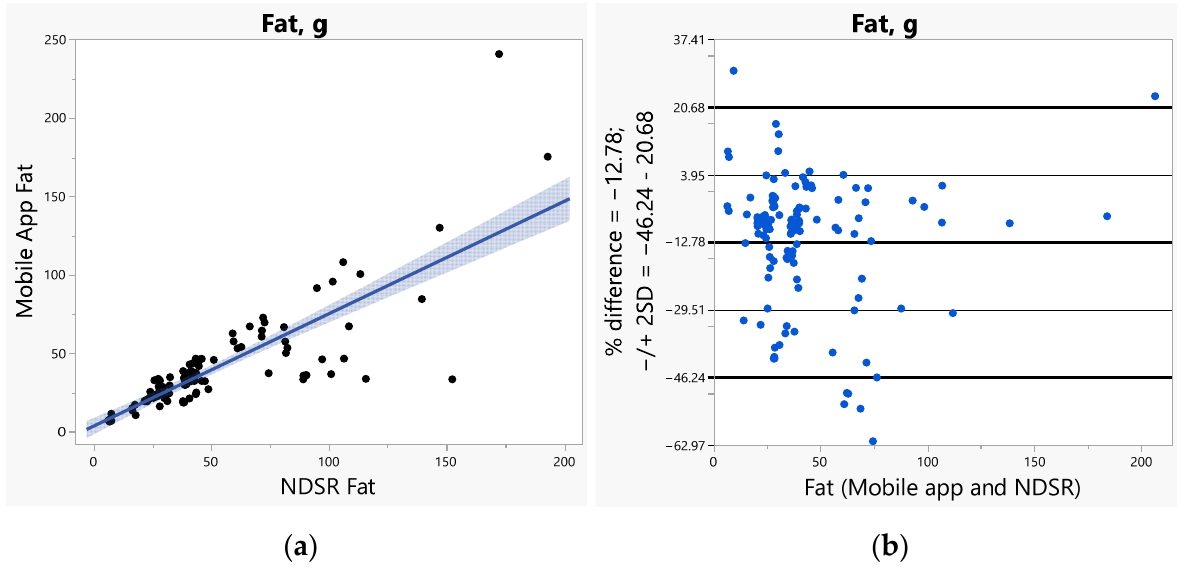
Figure 2. ( a ) Correlation, ( b ) Bland-Altman plots between the internet-based application and Nutri- tion Data System for Research (NDSR) on fat.